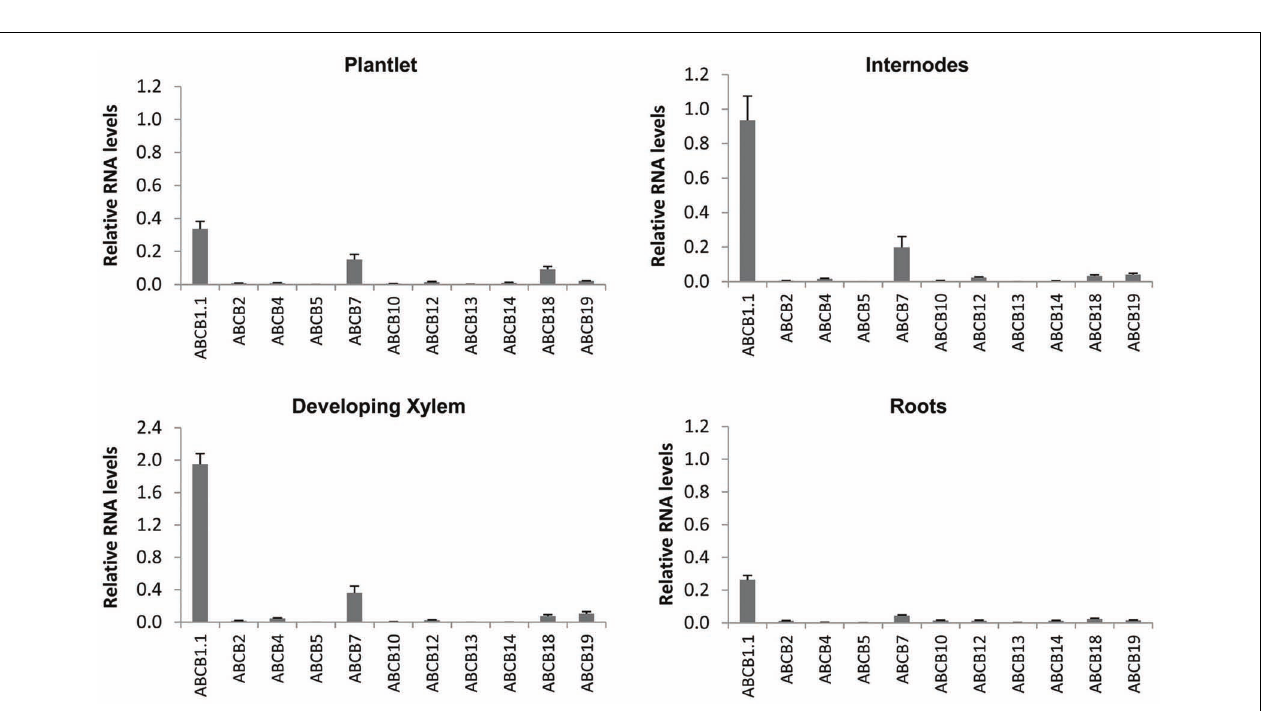
Arabidopsis ( AtABCB1 ) has been demonstrated to transport auxin. Expression patterns of all PtaABCB genes are previously undescribed. Error bars represent the